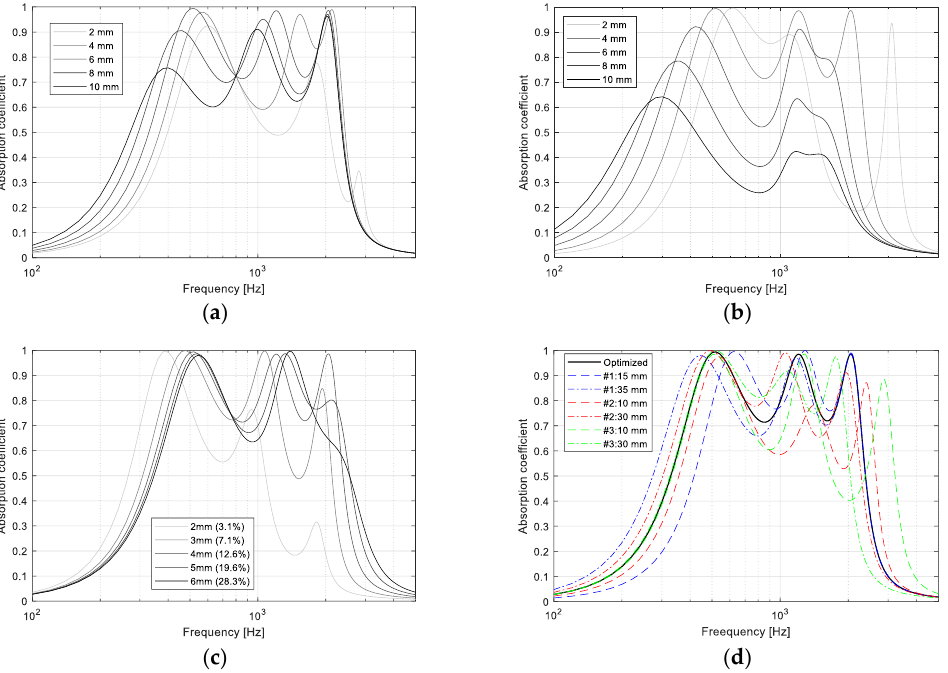
Figure 12. Comparison of the predicted sound absorption coefficients for triple-membrane structure as a function of individual parameter changes: ( a ) spacing of the first MPM; ( b ) spacing of the second MPM; ( c ) perforation rate of PP; and, ( d ) air gaps thickness. Reference parameters were: 25 mm back cavity; 1 st MPP with 6 mm spacing and 0.27 mm holes; 20 mm cavity; 2 nd MPP with 4 mm spacing and 0.27 holes; 20 mm cavity; PP with 4 mm holes with 10 mm spacing.